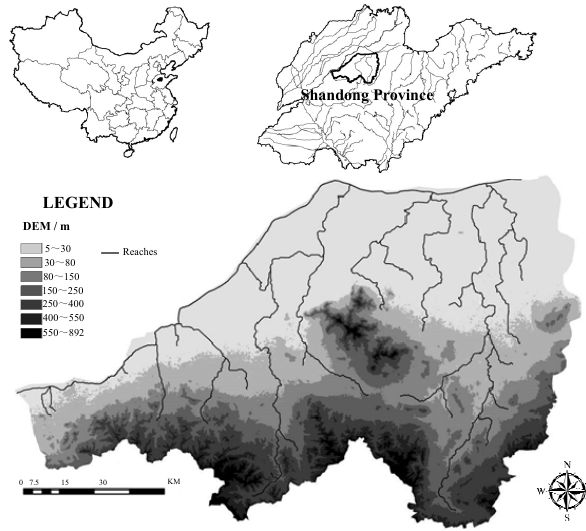
Figure 1. Location and DEM of the study catchment.